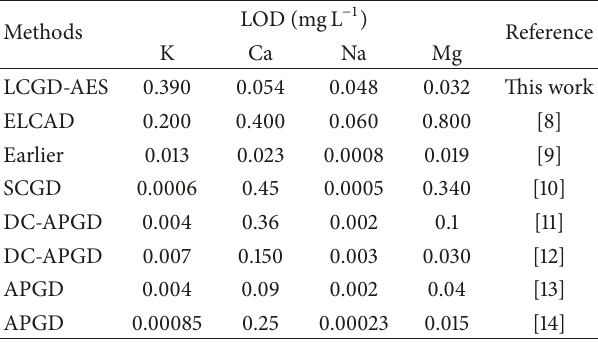
Table 2: Comparison of the LODs obtained by LCGD-AES system with other ELCAD-AES systems for the detection of K, Ca, Na, and